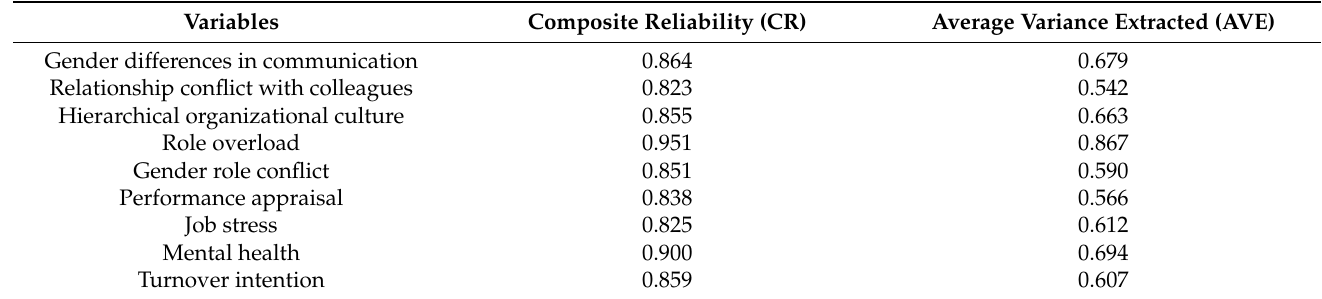
Table 3. Convergent validity analysis result.